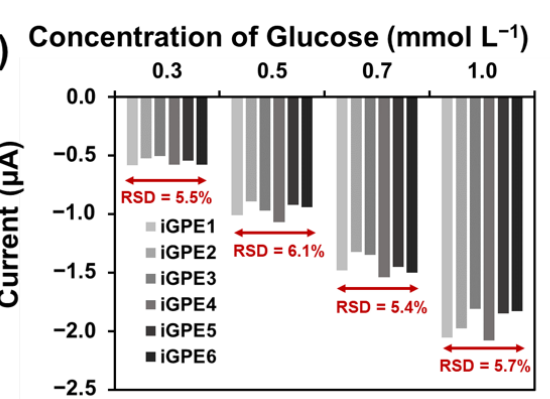
Figure 4. ( A ) Amperograms of PB/iGPE carried in 0.1 mol L − 1 PBS pH 7.4 containing 0.1 mol L − 1 KCl upon continuous injection of a standard solution of H 2 O 2 (from 0.01 to 3.00 mmol L − 1 ) at an applied potential of 0.0 V. ( B ) Linear range of H 2 O 2 at PB/iGPE obtained from amperograms in the concentration range from 0.01 to 3.00 mmol L − 1 . ( C ) Chronoamperograms toward glucose concentration range from 0.0 to 10 mmol L − 1 at GOx-PB/iGPE in 0.05 mol L − 1 PBS containing 0.10 mol L − 1 KCl at working potential of − 0.05 V. ( D ) Calibration curve toward glucose in a concentration range from 0.05 to 1.0 and from 1.0 to 5.5 mmol L − 1 recorded at 50 s. ( E ) Reproducibility of MF−iGPE toward different concentrations of glucose.